Question: In a single sentence, describe what this figure presents.
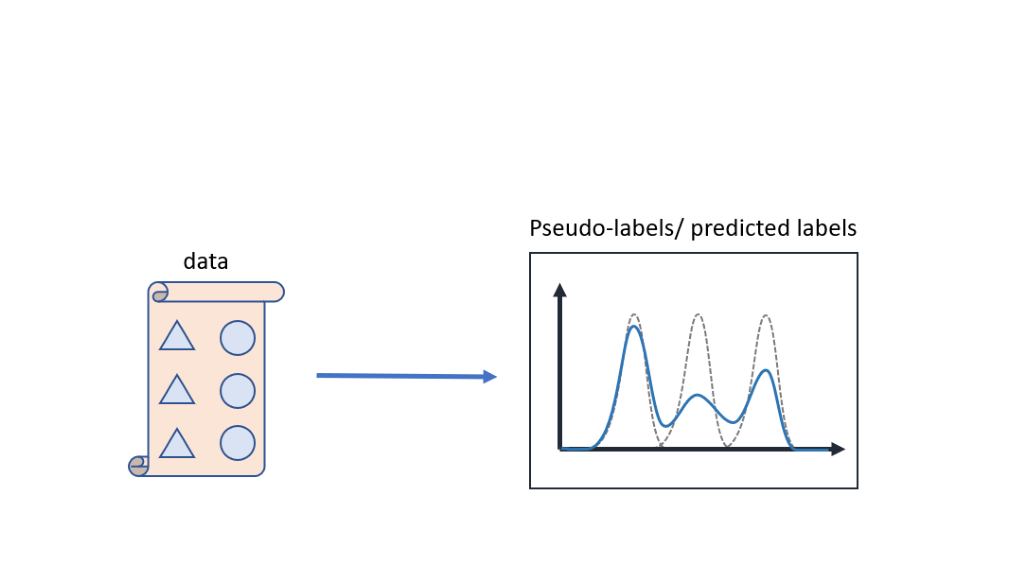
Answer: Uncertainty-aware representations. In the right part of this figure, dashed curves represent the basis distributions while the blue curve represent the uncertainty-aware representation and uncertainty-aware labels of the data. The expectation of the labels could be used as the final label and the variance could be used to evaluate the uncertainty.